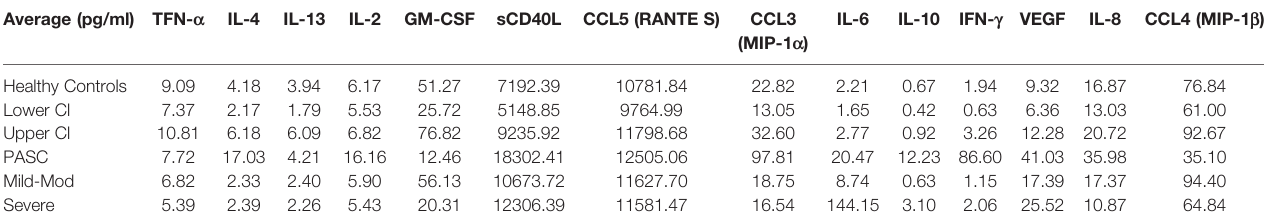
TABLE 1B | Cytokine and other soluble factors quanti fi cation.